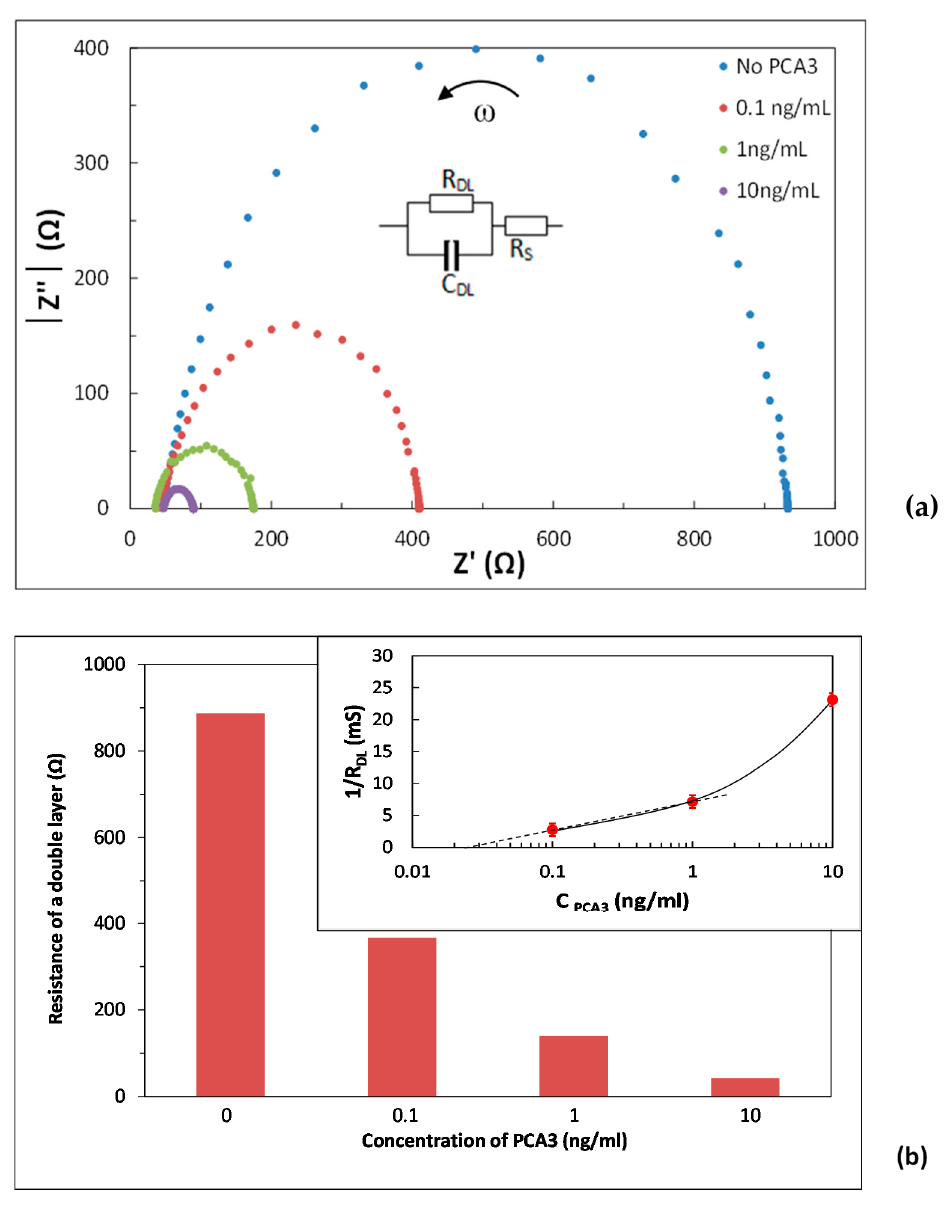
Figure 4. ( a ) A typical set of Nyquist plots for different concentrations of PCA3; ( b ) Concentration dependence of the resistance of a double layer. Inset illustrates the evaluation of LOD.